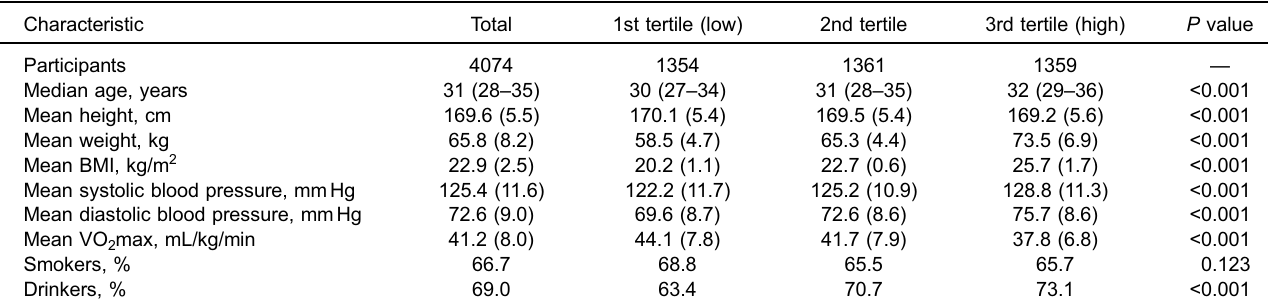
Table 1. Baseline characteristics of participants in 1985, according to BMI groups Characteristic